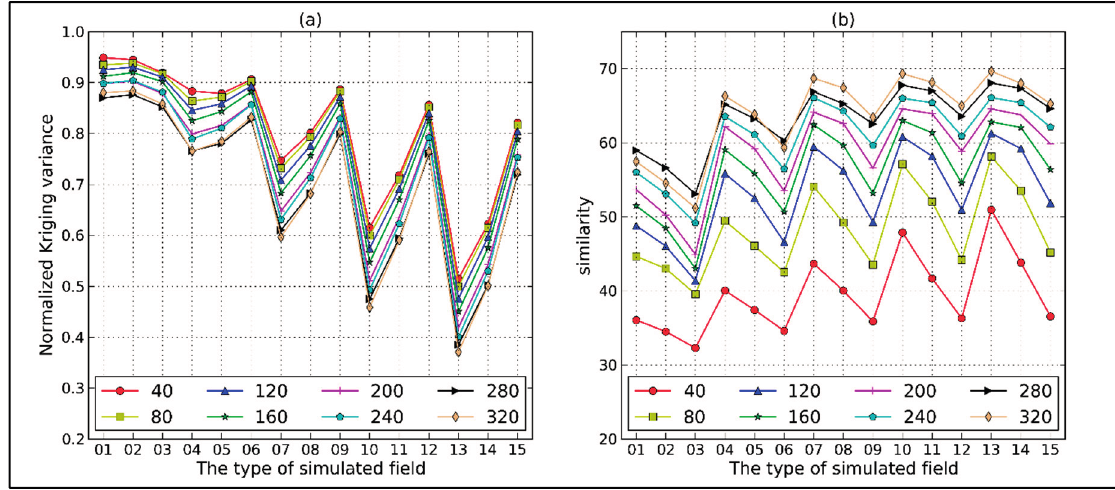
Figure 9. Normalized kriging variance ( a ) and similarities ( b ) between the simulated and estimated fields with different block